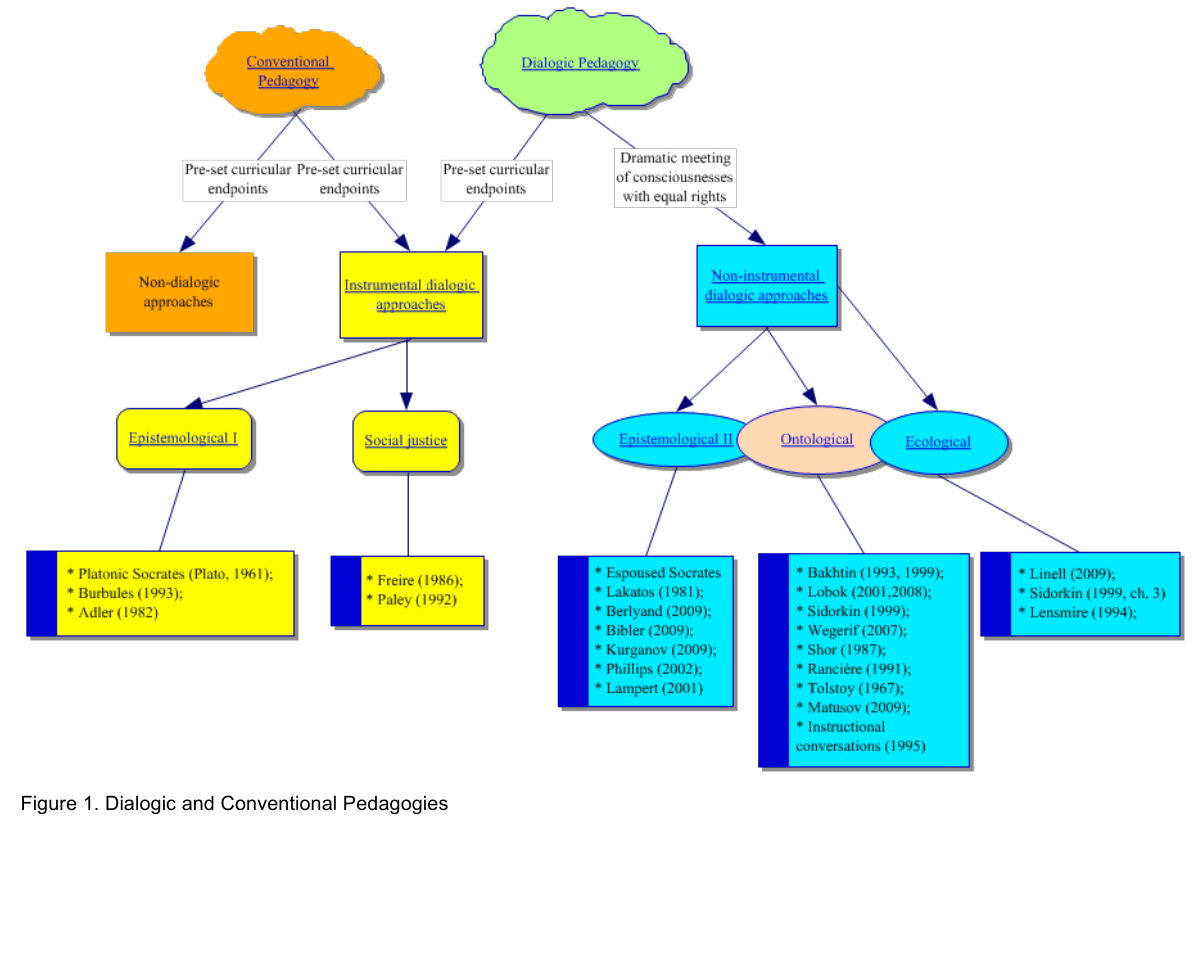
Figure 1. Dialogic and Conventional